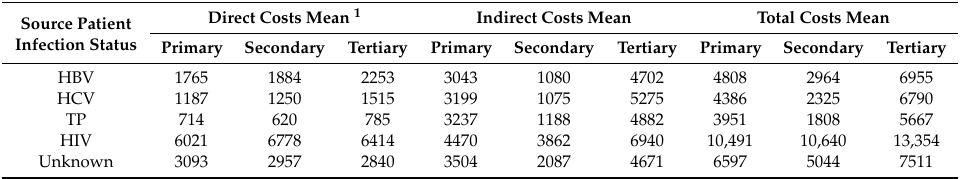
Table 5. Costs of the BBF exposure management categorized by the facility levels in Beijing (in Chinese RMB).